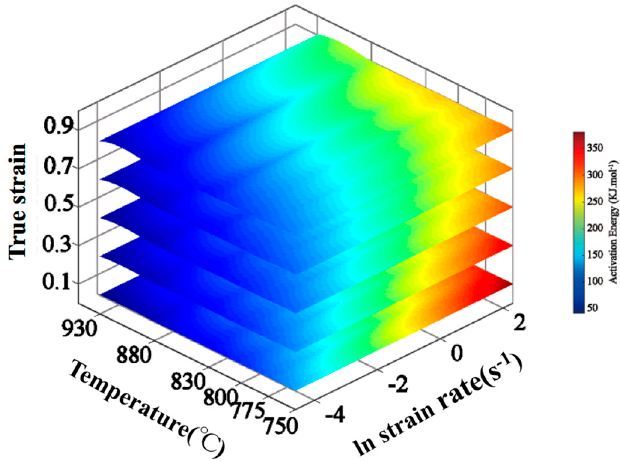
Figure 7. The 3D activation energy map of the Ti-35421 alloy obtained from modified hyperbolic sine mode.